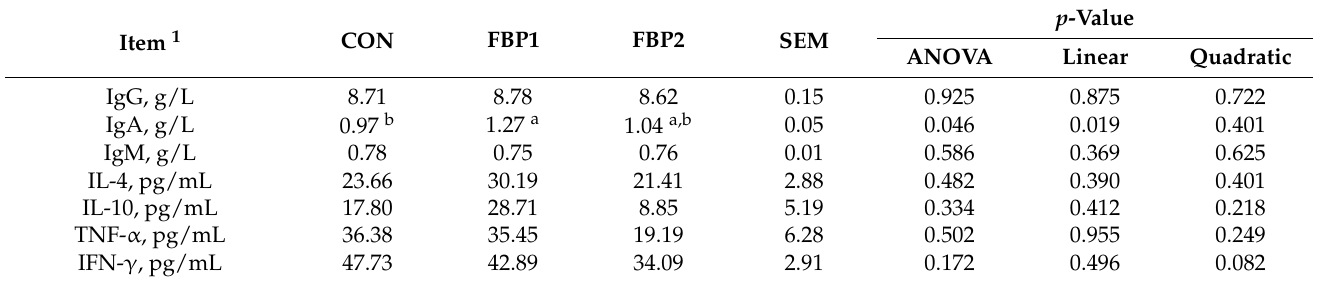
Table 3. Effects of fermented bamboo powder supplementation on serum immunoglobulins and inflammatory cytokines of growing–finishing